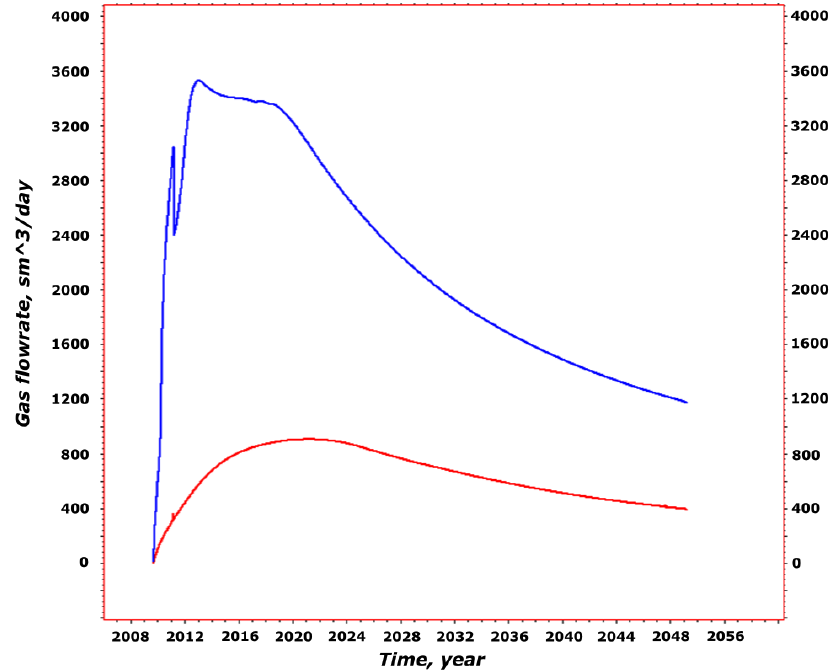
Figure 13. Daily CO 2 injection rate (the red color signifies the results of the simulation taking into account the phenomenon of coal matrix shrinking and swelling, while the blue one represents the simulation results, which do not include the phenomenon).